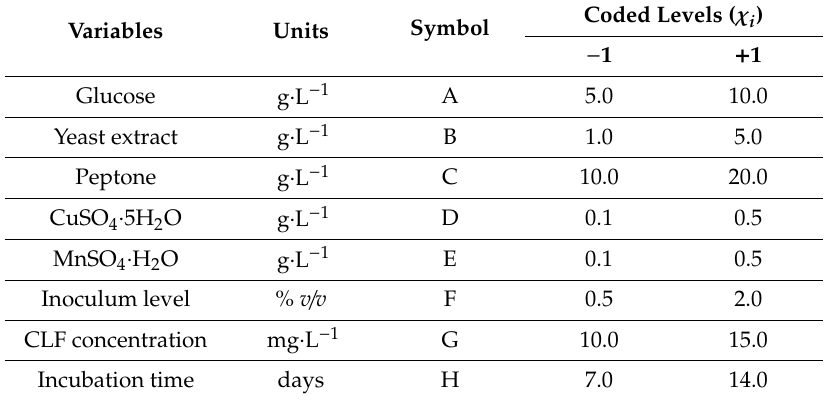
Table 1. The PBD for screening independent variables for CLF biodegradation by Trametes pubescens . Variables